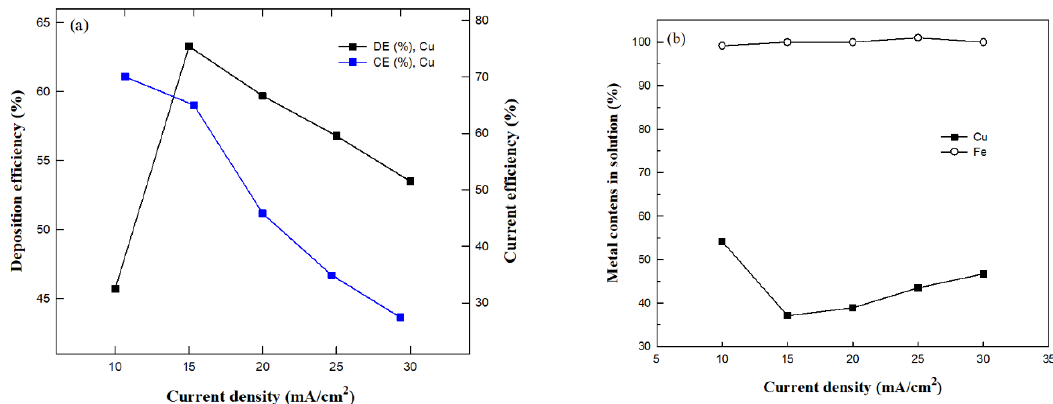
Figure 4. ( a ) Effect of current density on Cu deposition efficiency and current efficiency, ( b ) metal contents in the solution with the variation of current density. Electrodeposition conditions: H 2 SO 4 100 g/L, current density 10–30 mA/cm 2 , 4 h, 25 °C.